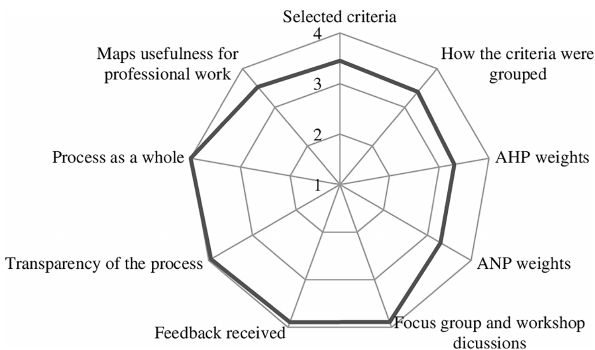
Figure 10. Participants satisfaction with several aspects of the par- ticipatory process (1, very unsatisfied; 2, unsatisfied; 3, satisfied; 4, very